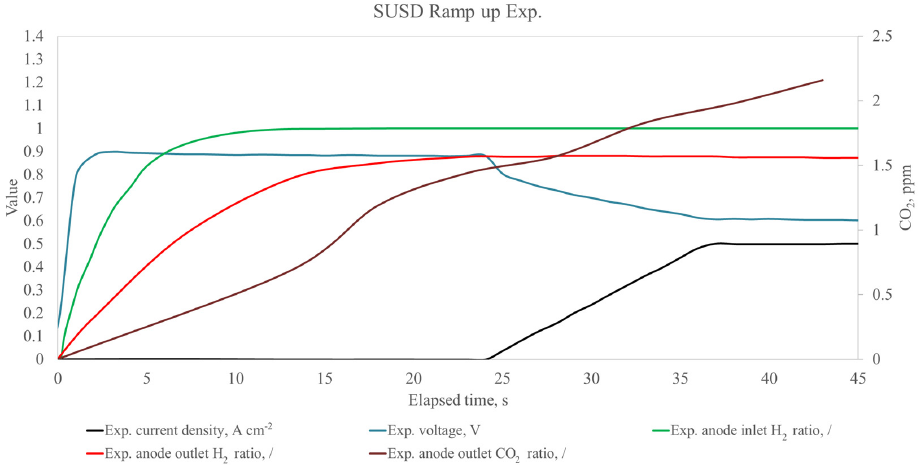
Figure 5. Measured gas compositions during start up.